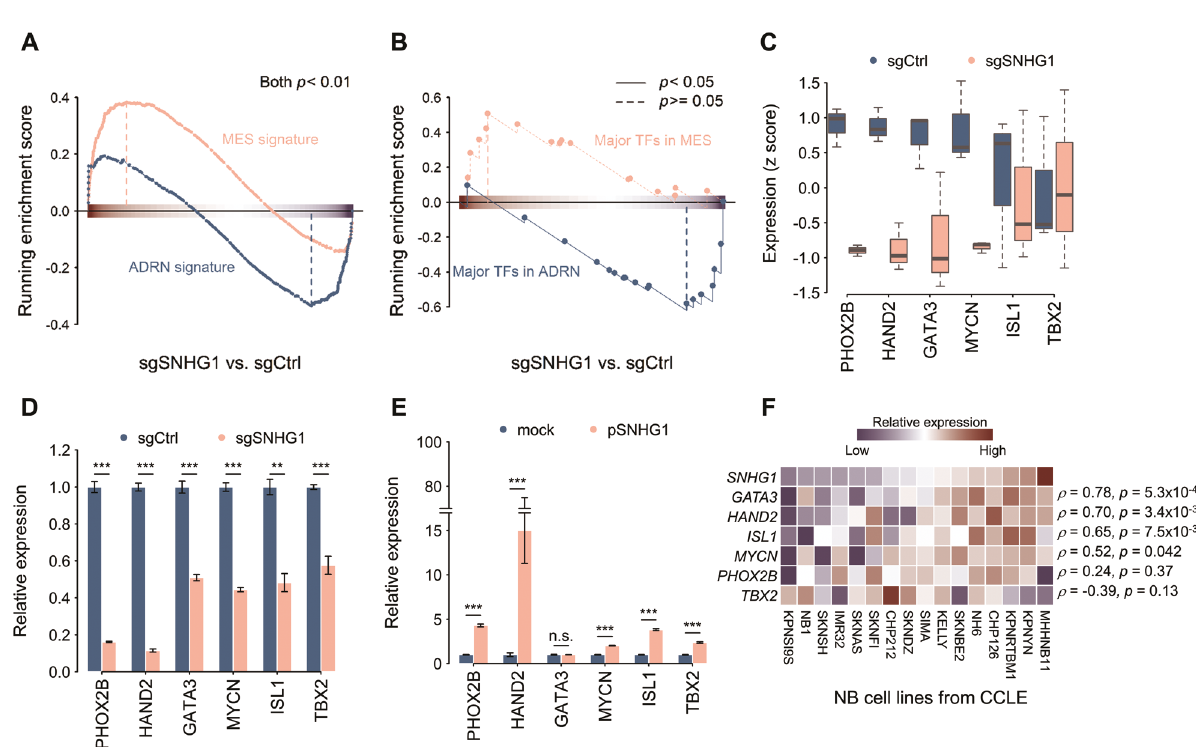
Fig. 3 SNHG1 -depletion decreased the expression of core regulatory circuit (CRC) transcription factors in neuroblastoma (NB) cells. A Mesenchymal (MES) and adrenergic (ADRN) signatures on the transcriptome pro fi les of SNHG1 -depletion and control NB cells. B The differential expression between SNHG1 -depletion and control NB cells were compared to the major transcriptional factors in the MES and ADRN cell states. C The expression of the CRC genes PHOX2B, HAND2, GATA3, ISL1, MYCN , and TBX2 in the RNA-seq results. ( n = 3). D CRC gene expression levels measured by qRT-PCR of control sgRNA (sgCtrl) or SNHG1 -speci fi c sgRNAs (sgSNHG1) in SK-N-BE(2)C cells. The expression levels were normalized to endogenous HPRT . ( n = 3). E To dissect the relationship between CRC genes and SNHG1 , SK-N-BE(2)C cells were transfected with a SNHG1 overexpressing plasmid. CRC gene expression levels were measured by qRT-PCR. The expression levels were normalized to endogenous HPRT . ( n = 3). F Gene expression heatmap of CRC genes and SNHG1 in various NB cell lines. ρ : Spearman ’ s correlation coef fi cient. * p < 0.05, ** p < 0.01, *** p < 0.001 from t